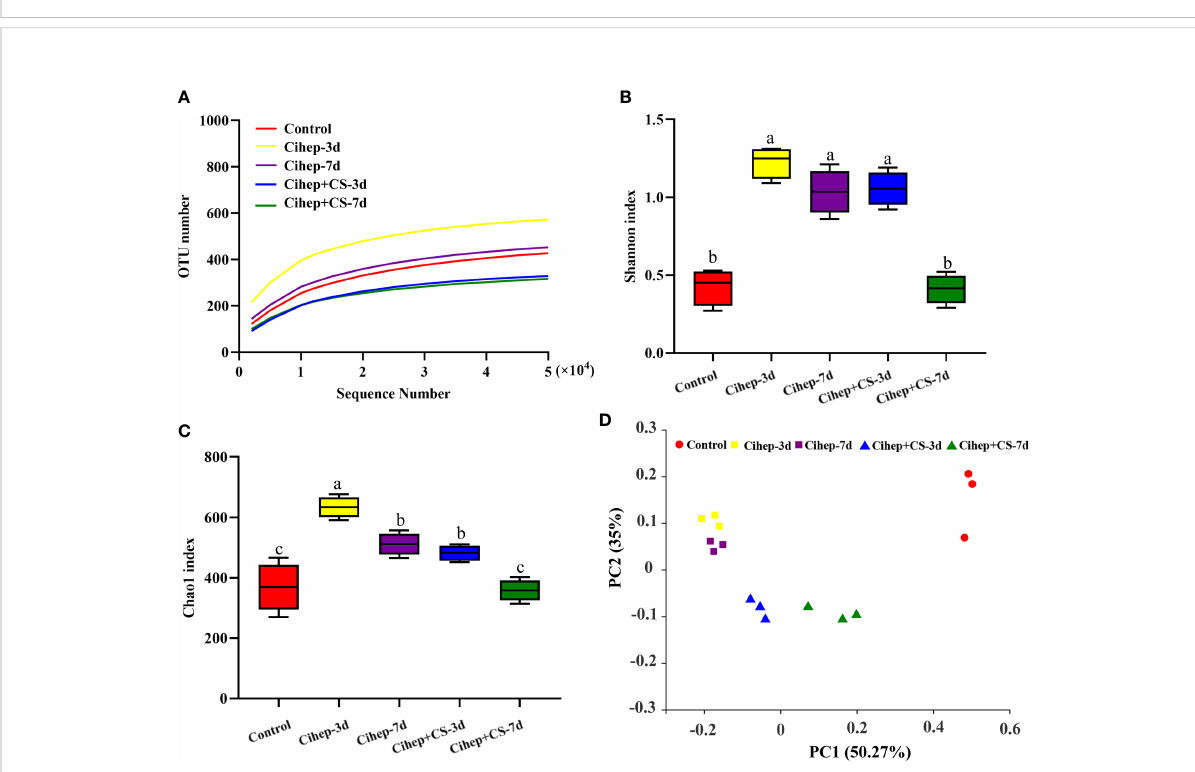
FIGURE 6 Intestinal 16S sequencing analysis of grass carp. (A) Rarefaction Observed species curves of OTUs clustered at 97% sequence (Y-axis indicates number of observed species). (B, C) Alpha-diversity index difference based on Chao1 metric and. Shannon index. (D) Beta-diversity index difference based on unweighted UniFrac. Different small letters in each group (a, b, and c) denote signi fi cant variations suggested by the multifactorial ANOVA statistics (p <